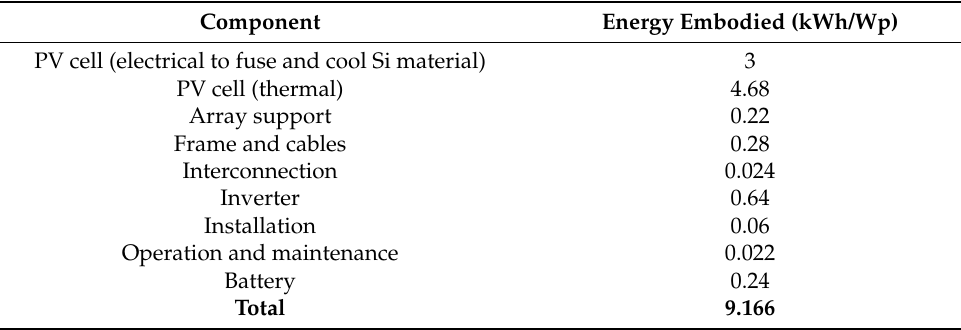
Table 6. Embodied energy of the PV system components. Component Energy Embodied (kWh/Wp) PV cell (electrical to fuse and cool Si material) 3 PV cell (thermal) 4.68 Array support